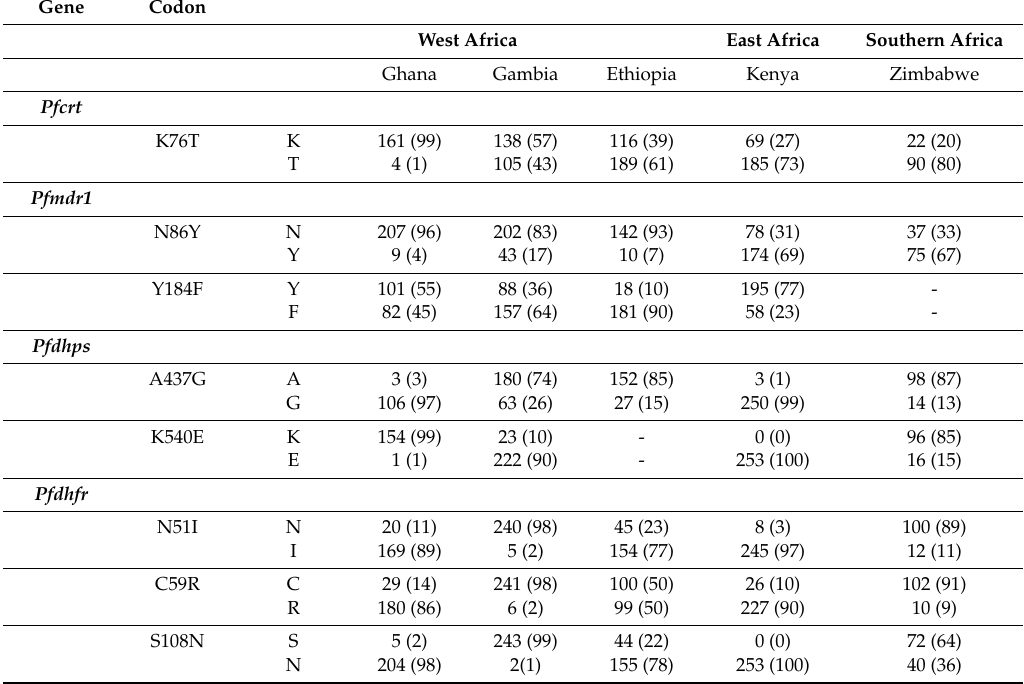
Table 3. Comparison of prevalence of the Pfcrt , Pfmdr1 , Pfdhfr , and Pfdhps point mutations in P. falciparum from West (Ghana from this study; Gambia [27]), East (Ethiopia [28]; Kenya [29], and Southern Africa (Zimbabwe